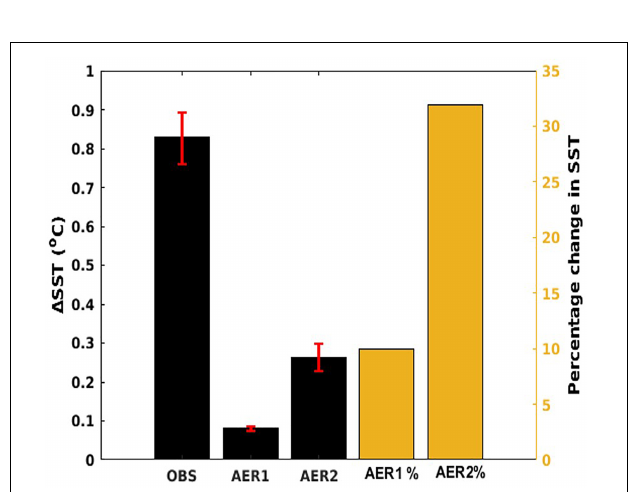
FIGURE 5 | The total warming observed during April 2020 and that attributed to aerosols (AER1 and AER2). The yellow bar represents the aerosol-led warming in percentage (corresponding to the y -axis shown to the right). The error bar represents the standard error estimated from the spatial distribution.